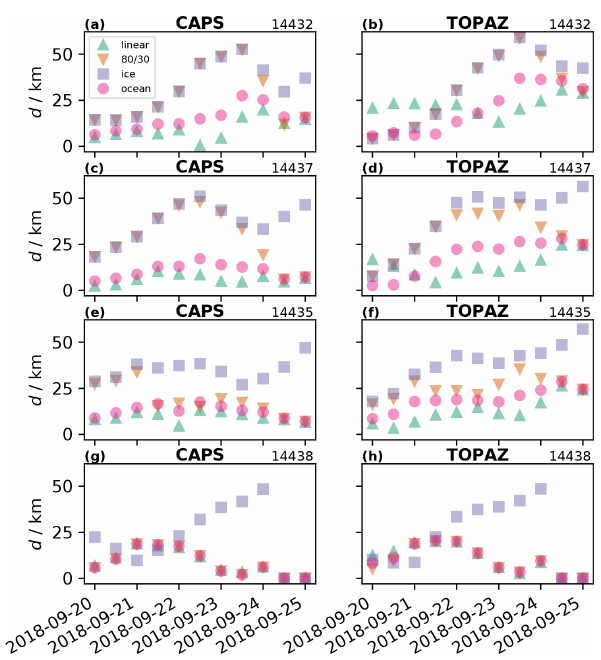
Figure 7. Drifter separation ( d in km) after 48h. The horizontal axis denotes the start times for each simulation so that d is measured at 48h after the time shown on the axis. The linear model corresponds to Eq. (3) and the 80 / 30 model to (1), ice corresponds to the predic- tion with just ice velocities with no leeway, and ocean corresponds to the prediction with just ocean velocities plus 3% leeway. The solid horizontal lines show the mean separation distance for each respective drift model. The inclusion of a leeway coefficient does reduce separation distance between observed and predicted trajec- tories, with the linear weighted model providing the best